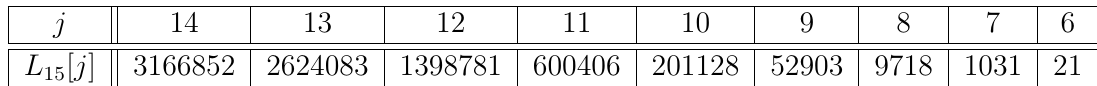
[ N ]) connected graphical 7